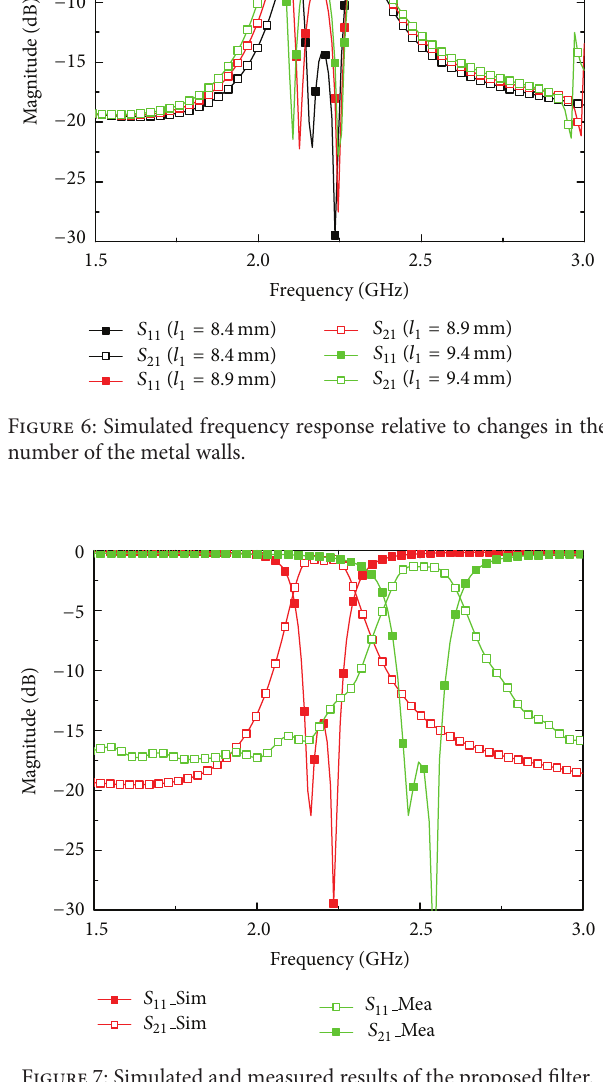
Figure 7: Simulated and measured results of the proposed